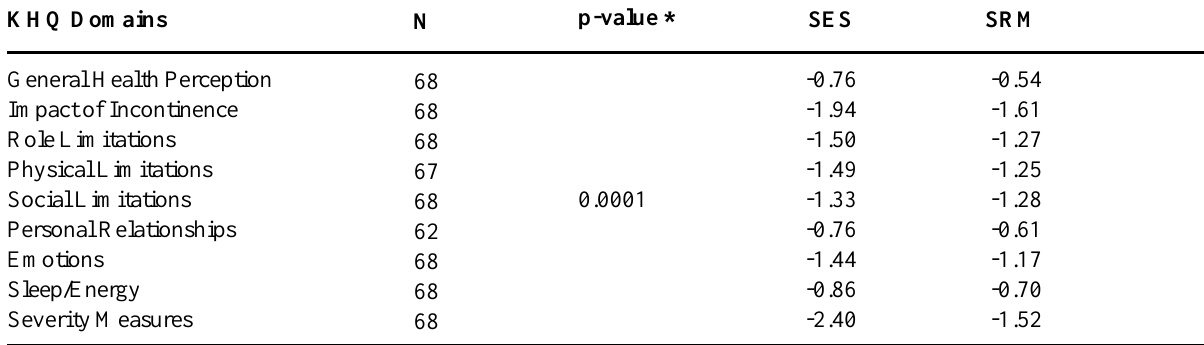
Table 4 – Study of the internal responsiveness of King’s Health Questionnaire - KHQ (sensitivity to change), using Effect